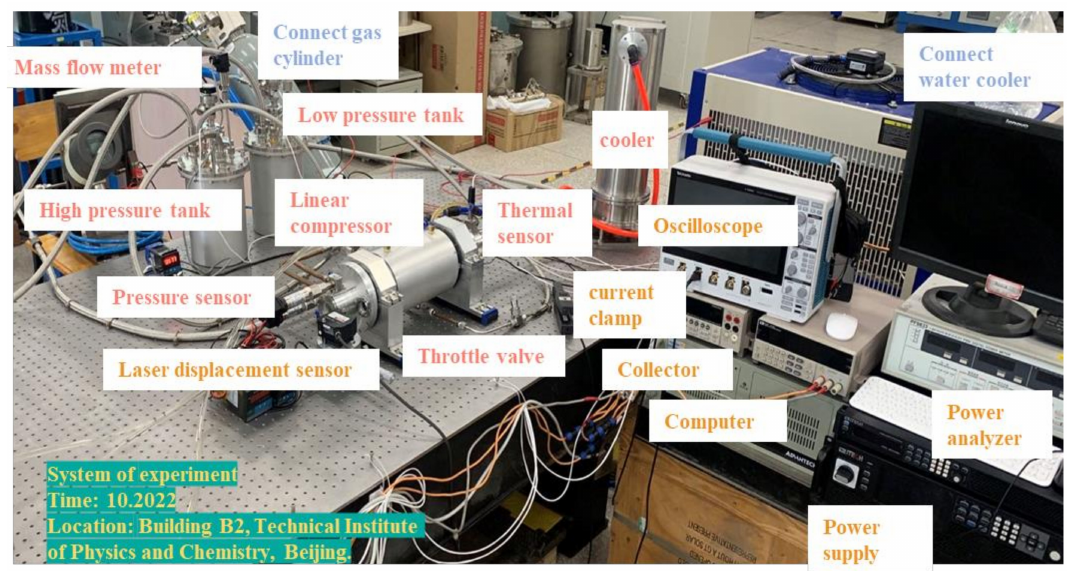
Figure 12. Photo of the experimental system.